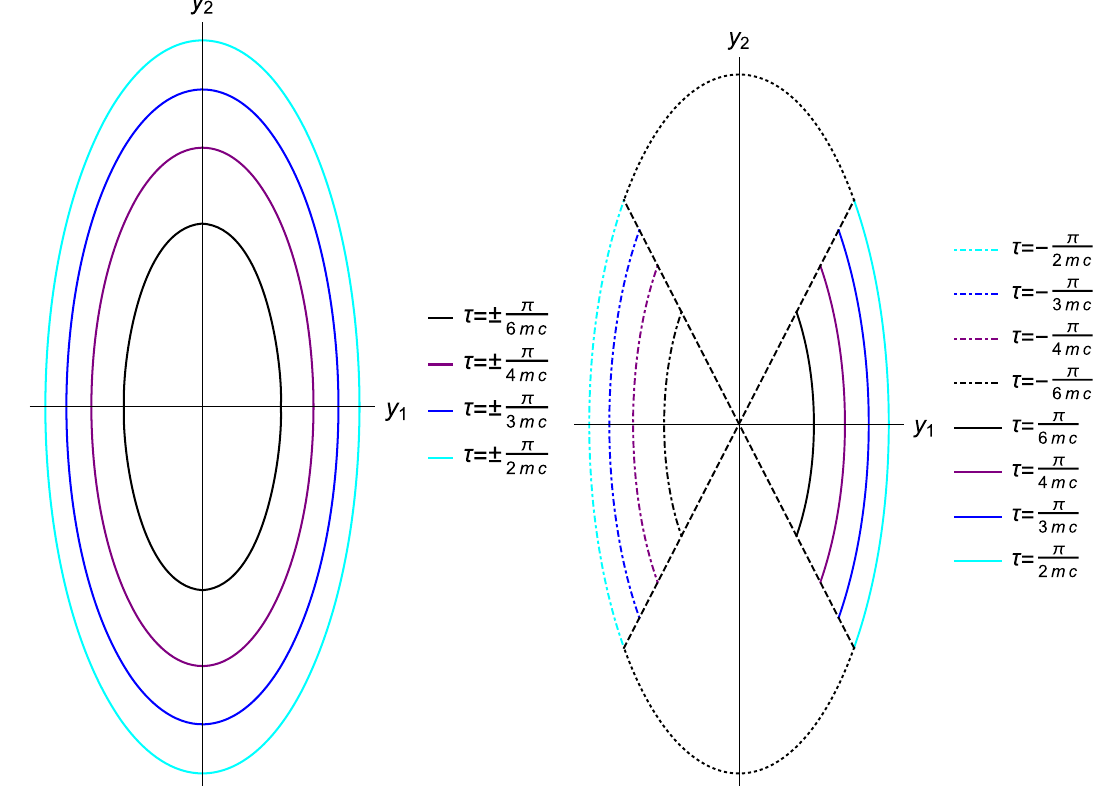
Fig. 6 Indicative static solutions of the SU ( 2 )/ U ( 1 ) model. The left panel corresponds to a rotating solution, while the right one to an oscillating one, which is a folded string. Notice that as λ > 0 the angle ψ of the oscillating solution “oscillates” around 0. The equation of the cyan ellipses is